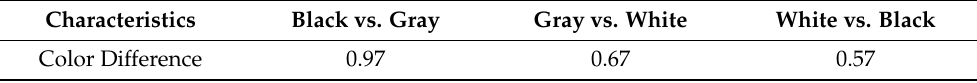
Figure 7. Color difference between the afterimage and background ( a ) with different background levels at 1 and 5 s; ( b ) with different exposure times and luminance levels. Table 7. The correlation coefficient of the color difference between each